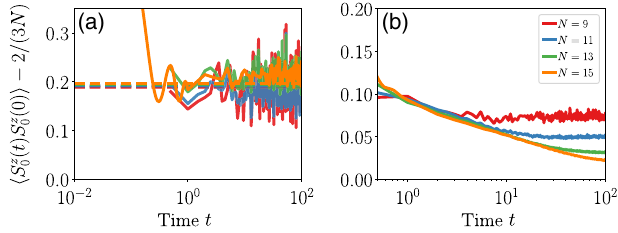
FIG. 11. (a) Density of states (DOS) for the Hamiltonian H 3 in Eq. (1) for system size N ¼ 13 . (b) Distribution of dimensions D for the H invariant subspaces. Each curve corresponds ð q;p Þ ð q;p Þ to a subspace with fixed charge q .